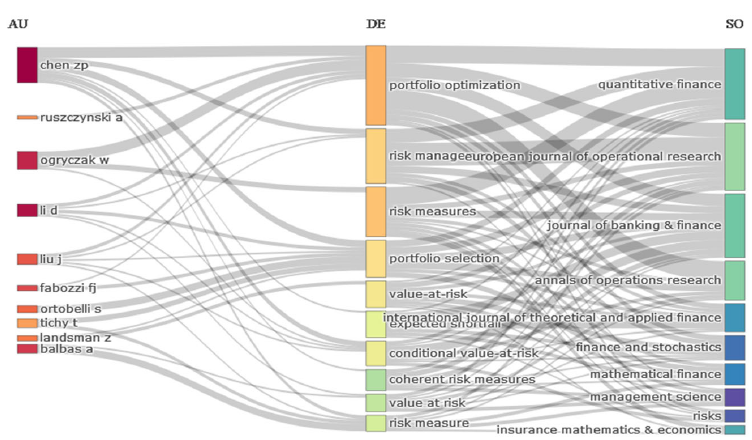
Fig. 4. Three-Field